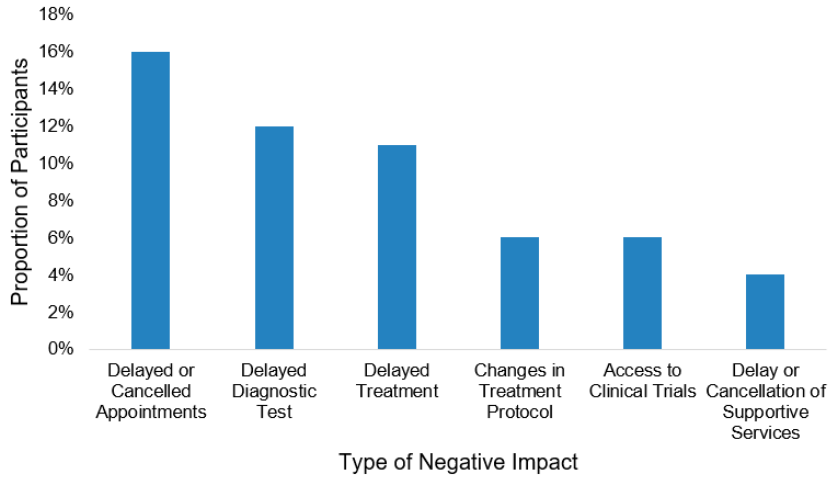
Figure 1. Type of negative impact of the COVID-19 pandemic on cancer care ( n = 173).